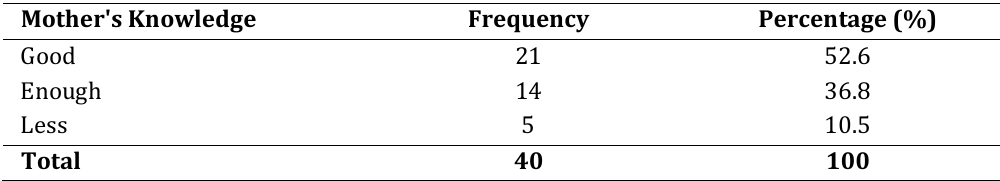
Characteristics of respondents Based on Mother's Knowledge Mother's Knowledge